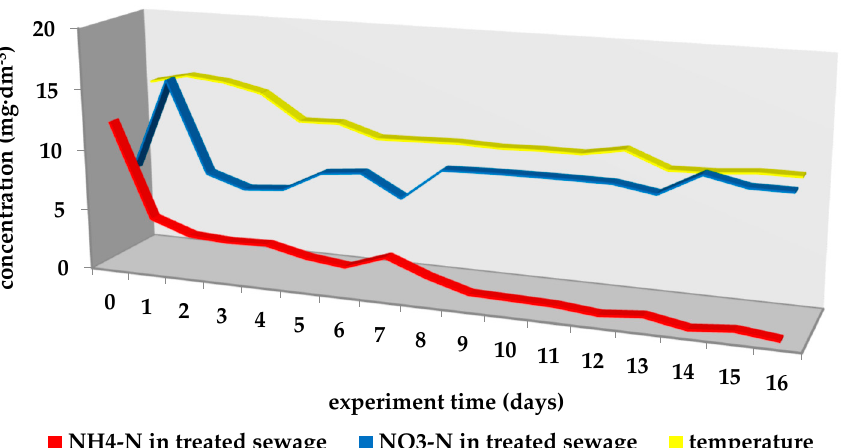
Figure 7. The influence of nitrifying bacteria cultures settled in the activated sludge on the efficiency of nitrification in the biological wastewater treatment system in the Municipal and Industrial Sewage Treatment Plant in O´swi˛ecim.